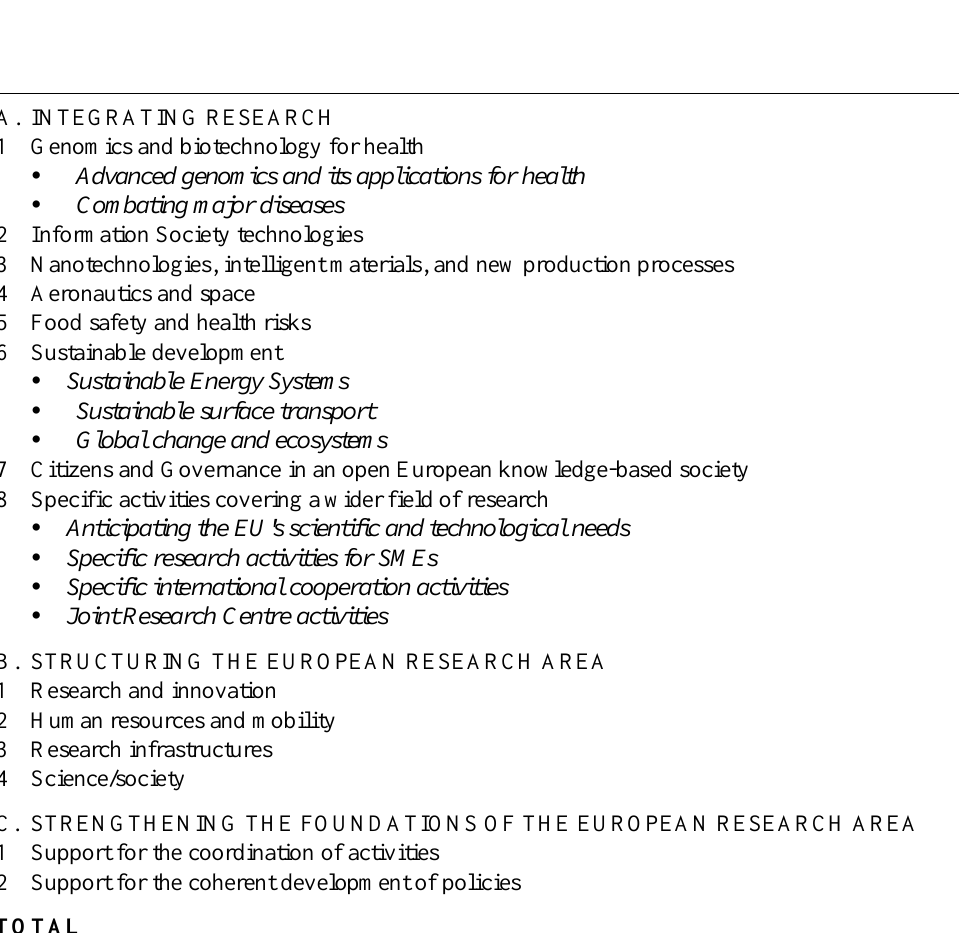
Table 2. Indicative Budget of the Sixth Framework Programme (in (cid:128) million)